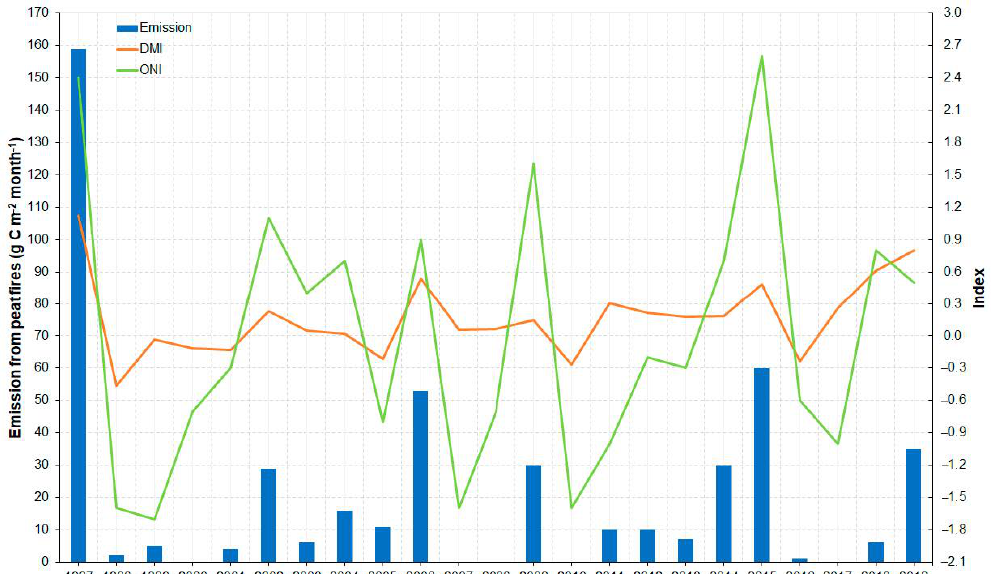
Figure 1. Estimated annual emission of peatland fires in Equatorial Asia in 1997–2019 from Global Fire Emissions Database version 4.1 (http: // www.globalfiredata.org / data.html) and the Oceanic Niño Index (ONI) and Dipole Mode Index (DMI) using 3 month running average of sea surface temperature anomalies during November-December-January period. Climate indices data were accessed at https: // origin.cpc.ncep.noaa.gov / products / analysis_monitoring / ensostu ff/ ONI_v5.php and https: // psl. noaa.gov / gcos_wgsp / Timeseries / Data /